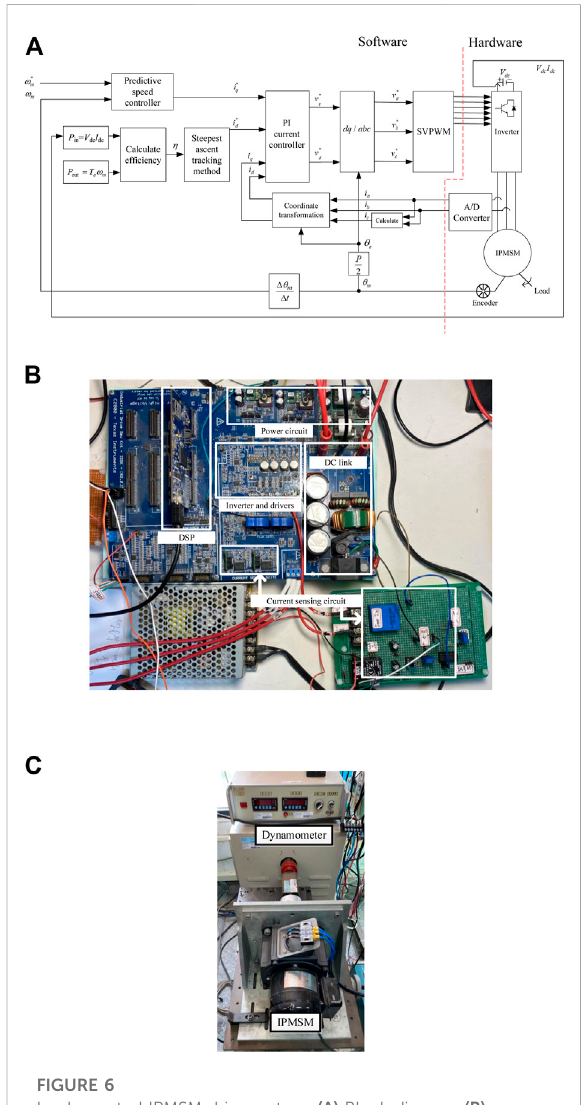
FIGURE 6 Implemented IPMSM drive system. (A) Block diagram (B) hardware circuit (C) dynamometer.